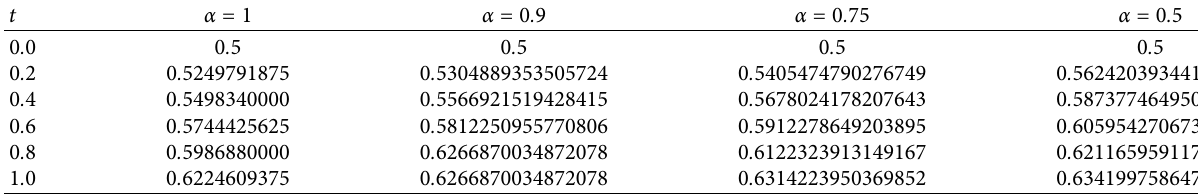
Table 3: The 5 th FRPS solution of Example 1 for several values t and α .